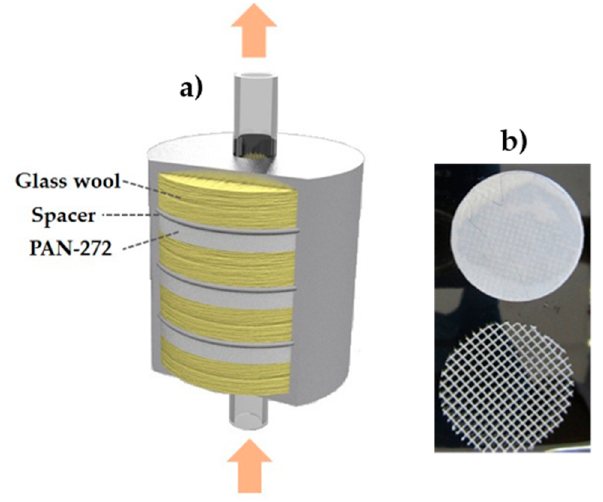
Figure 1. ( a ) Scheme of the cartridge filter design and ( b ) nanofiber membrane and spacer.